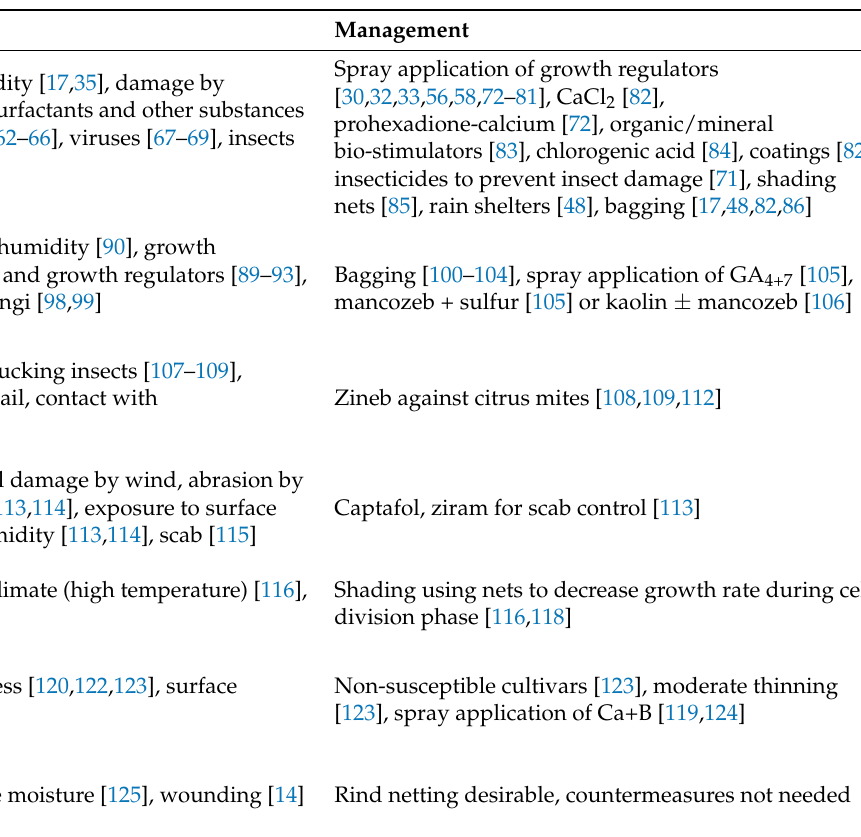
Table 1. Occurrence, symptoms, causes and management of russeting. Results are compiled from literature